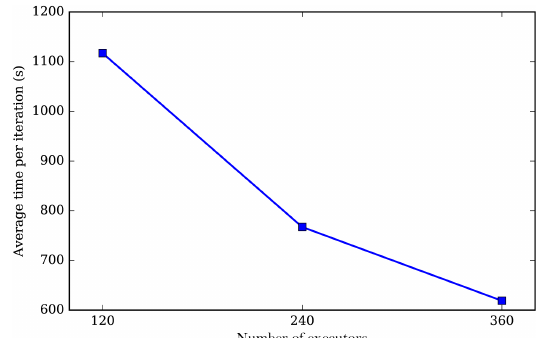
Fig. 9 Averaged execution time per iteration as executor number varies. checkpoints automatically if some machines are lost.